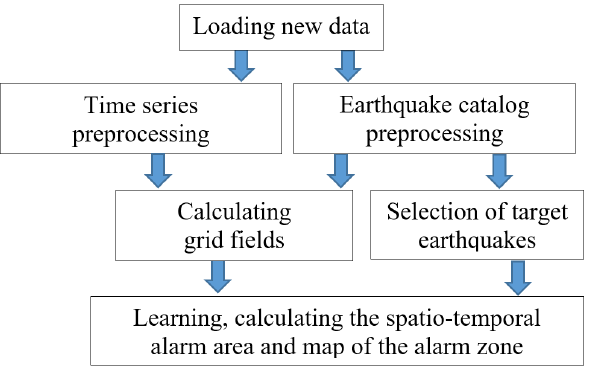
Figure 1. Flowchart of operations in the intervals ∆ t before the